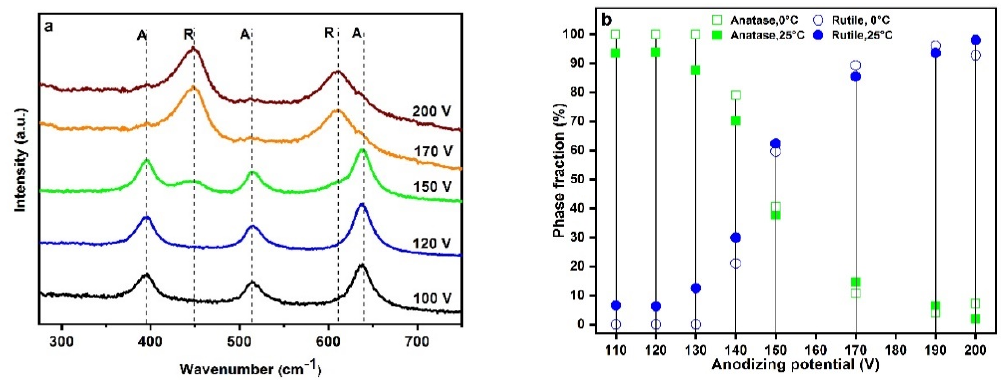
Figure 3. Raman spectra of TiO 2 films formed at varying potentials at 0 °C ( a ). A and R stand for anatase and rutile, respectively); anatase and rutile phase fractions calculated on the basis of the XRD patterns as functions of PEO potential at 0 and 25 °C ( b ).